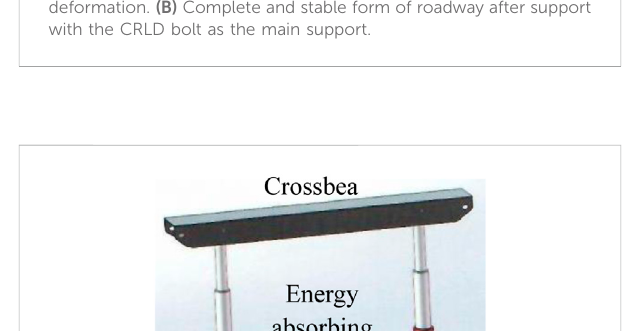
FIGURE 7 Comparison of before and after roadway support in Xin ’ an Coal Mine, Henan Province, China. (A) Roadway cross-section deformation. (B) Complete and stable form of roadway after support with the CRLD bolt as the main support.